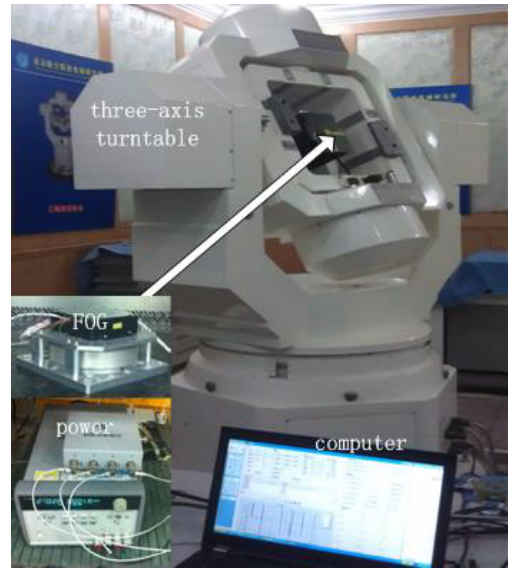
Figure 3. Experimental setup of FOG.